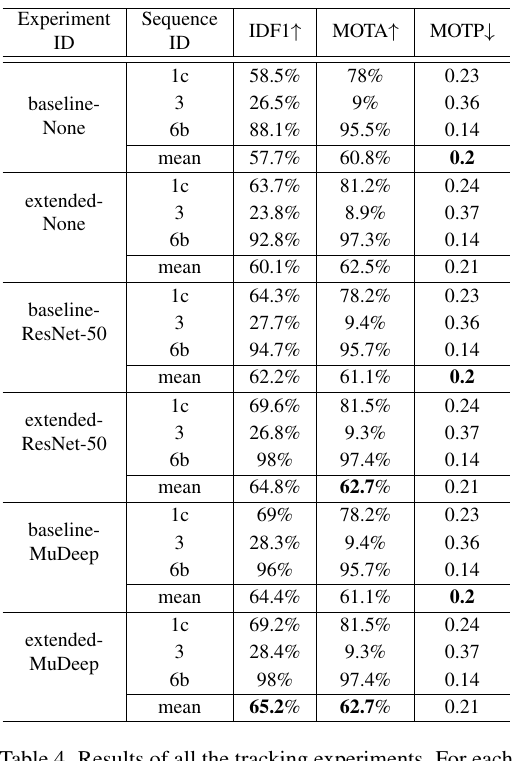
Table 4. Results of all the tracking experiments. For each experiment, we report the scores of each video sequence. The last row of each experiment shows the average scores of all the three video